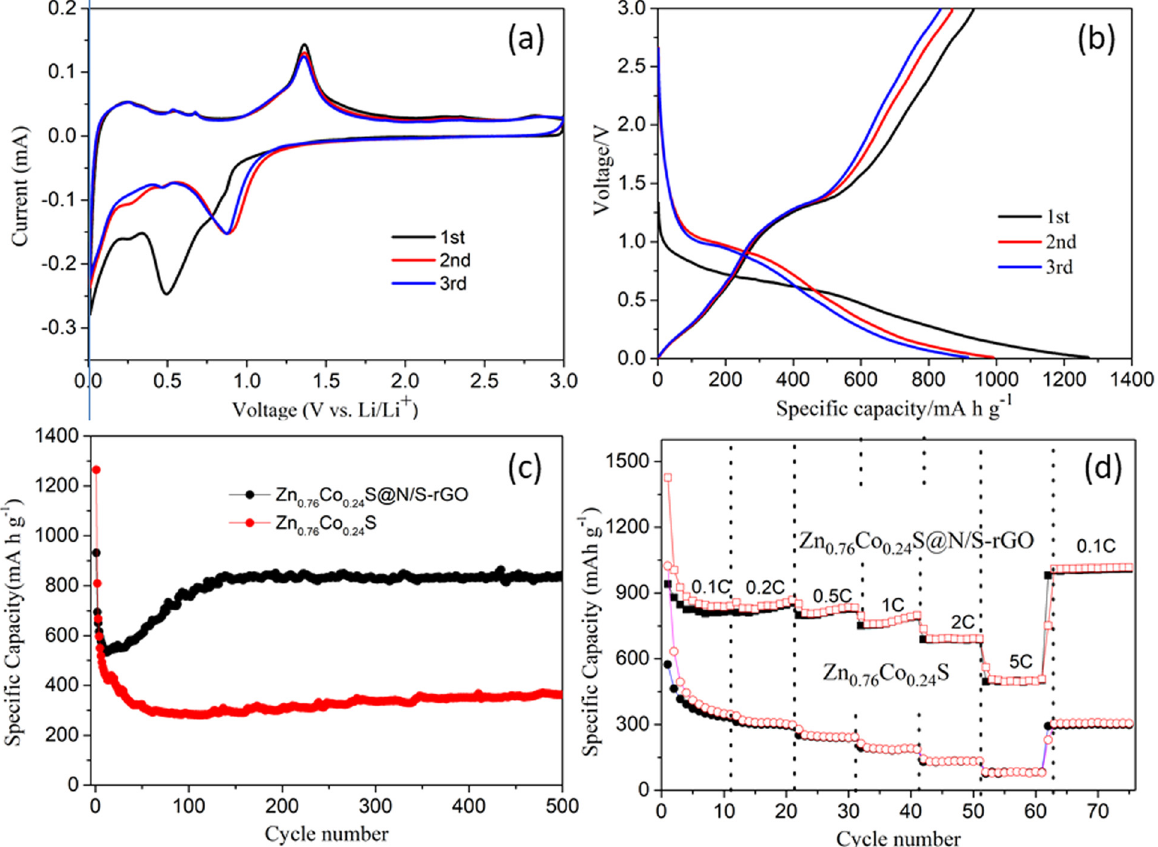
Figure 5: Lithium ion storage behaviours of Zn 0.76 Co 0.24 S@N/S - rGO and Zn 0.76 Co 0.24 S composite electrodes: ( a ) cyclic voltammetry curves of Zn 0.76 Co 0.24 S@N/S - rGO between 0.01 and 3 V with a scan rate of 0.1 mV s − 1 ; ( b ) charge/discharge voltage pro fi les of Zn 0.76 Co 0.24 S@N/S - rGO at a rate of 0.1 A g − 1 ; ( c ) cycling performance of the two di ff erent materials at a current density of 1 A g − 1 ; and ( d ) rate performance of two di ff erent